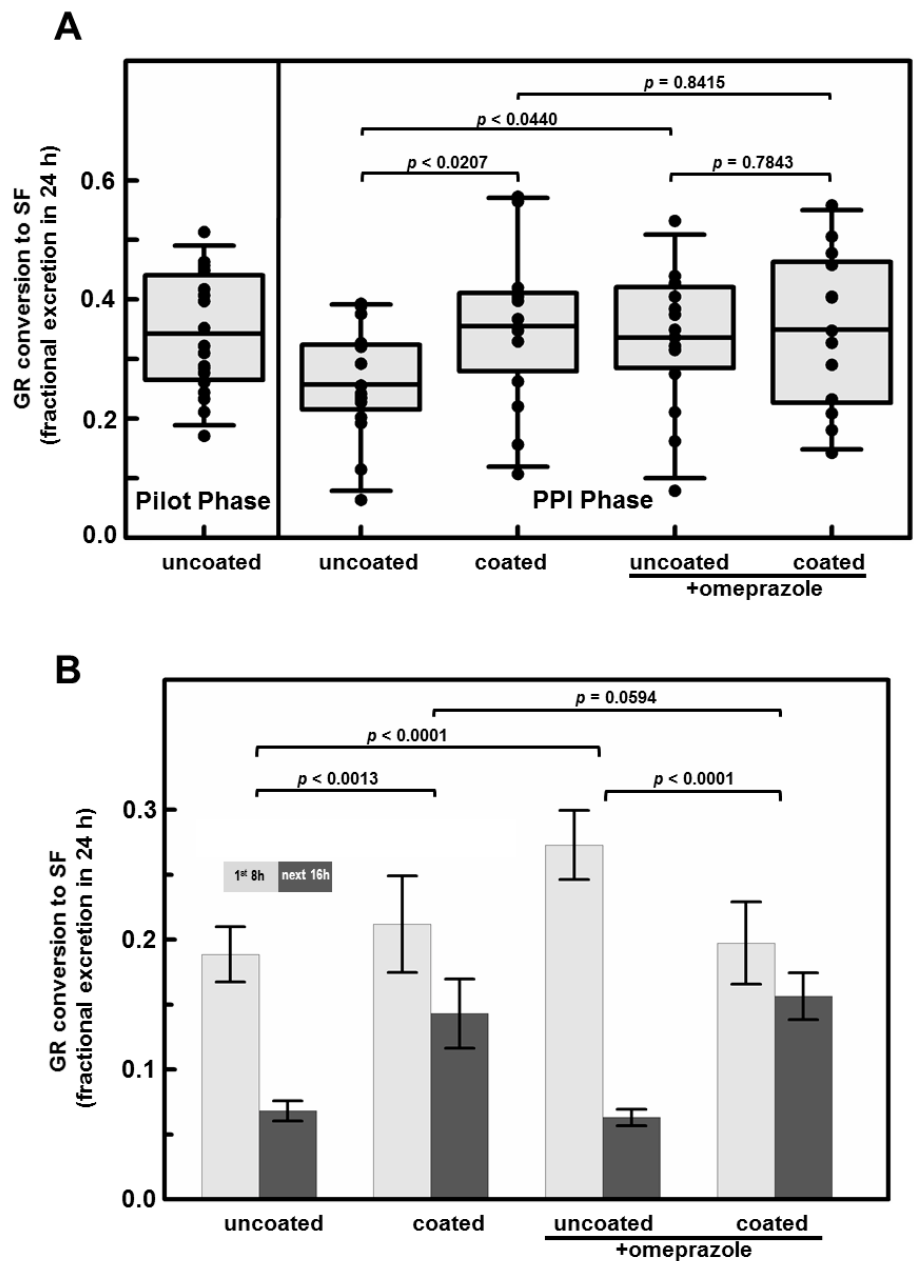
Figure 2. ( A ) Bioavailability following a single oral dose of a broccoli seed and sprout extract (BSE) containing GR and active myrosinase, as a function of treatment. There was a significant di ff erence by paired t -test between uncoated and coated administration, prior to omeprazole administration ( p < 0.0207), and a significant increase in bioavailability from uncoated tablets given after- compared to before- PPI administration ( p < 0.0440). Error bars represent the 5th and 95th percentile of the confidence interval around the mean, and boxes bracket the middle 50% of the distribution range. ( B ) Excretion of SF metabolites following a single oral dose of BSE containing GR and active myrosinase, in urine collected over 1st 8 h post-dose (0–8 h) and the following 16 h (8–24 h). Paired t -tests for di ff erences between 1st 8 h and next 16 h were highly significant for treatments in which tablets were uncoated ( p < 0.0001), but not significant for treatments in which tablets were enteric-coated ( p = 0.0594). Tablet coating significantly delayed conversion both prior to omeprazole treatment ( p < 0.0013) and following omeprazole treatment ( p < 0.0001). Error bars represent S.E.M.